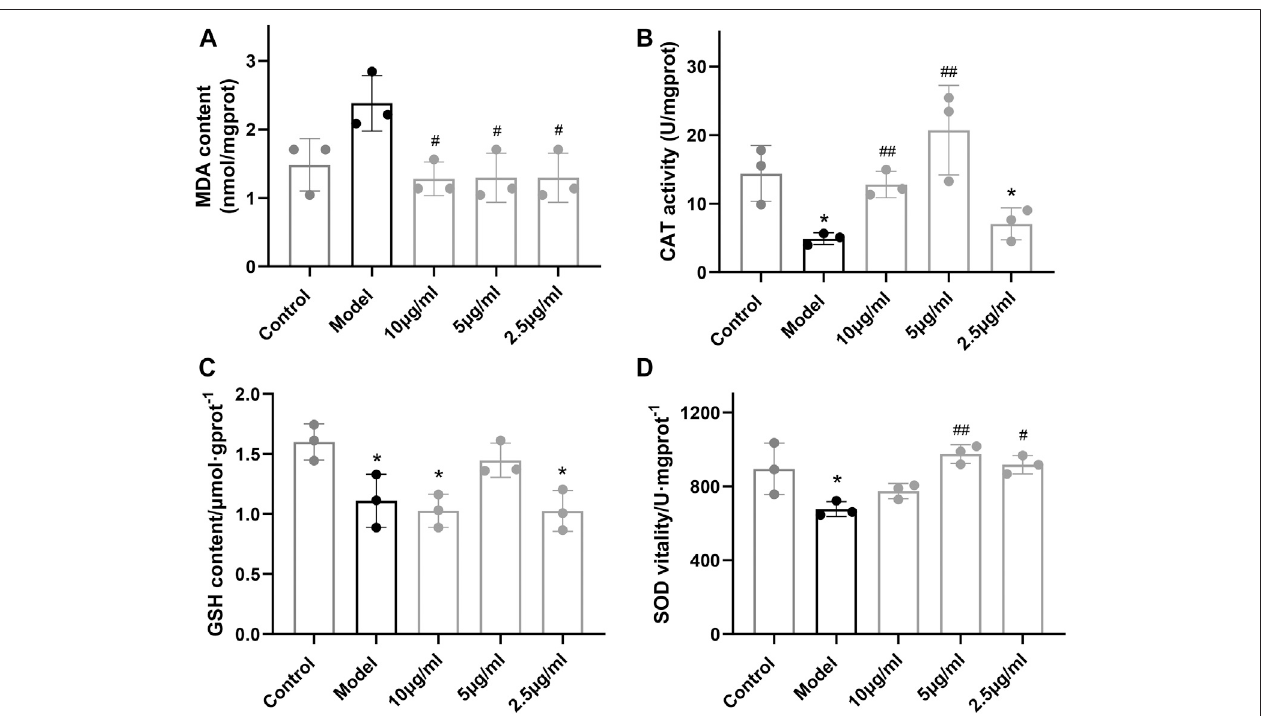
FIGURE 3 | Effect of DHT – BSA NPs on SOD, CAT, GSH, and MDA levels in PC12 cells. (A) The effect of DHT – BSA NPs on the change of MDA content in PC12 cells after treatment with 500 μ M H 2 O 2 . (B) The effect of DHT – BSA NPs on the change of CAT enzyme activity in PC12 cells after treatment with 500 μ M H 2 O 2 . (C) The effect of DHT – BSA NPs on the change of GSH content in PC12 cells after treatment with 500 μ M H 2 O 2 . (D) The effect of DHT – BSA NPs on the change of SOD enzyme activity in PC12 cells after treatment with 500 μ M H 2 O 2 . The data represent the mean ± SD ( n (cid:1) 3 in each group). * p < 0.05 vs. control; # p < 0.05 and ## p < 0.01 vs.